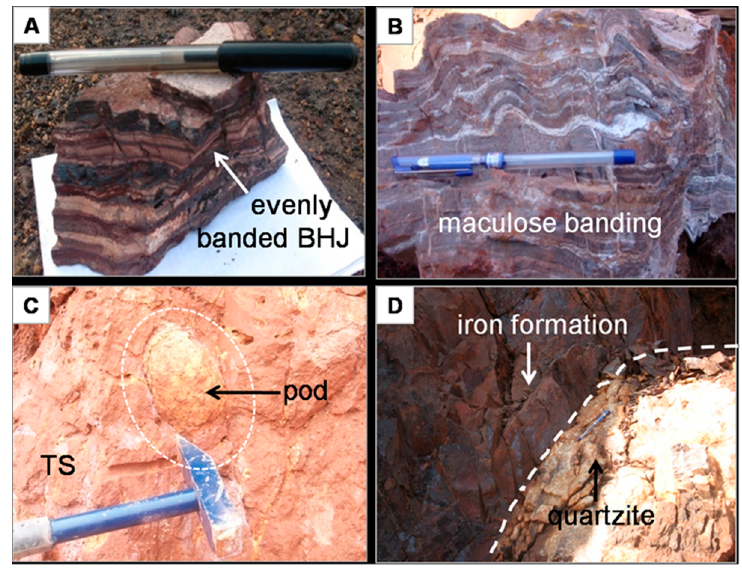
Figure 6. ( A ) Close-up view of evenly banded BHJ at places crumpled due to effect of deformation; ( B ) maculosebanding in BHJ; ( C ) pod structure occurring within tuffaceous shale (TS); and ( D ) Cherty quartzite associated with the iron formation.